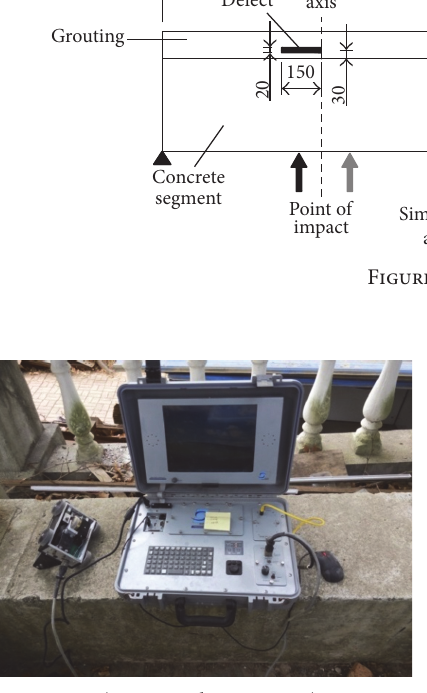
Figure 4: IES (Impact Echo Scanning)